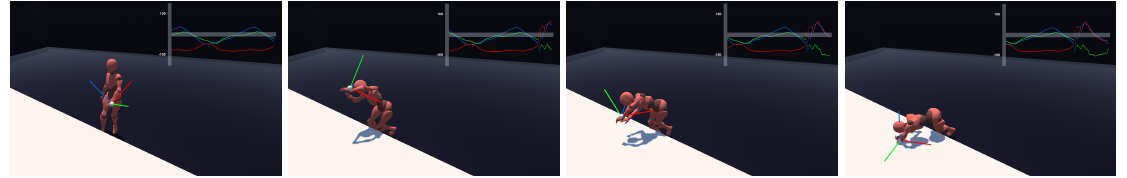
Figure 2. Recreation of a forward fall in the simulator. Triaxial accelerometer measures are provided in the top-right of each step.